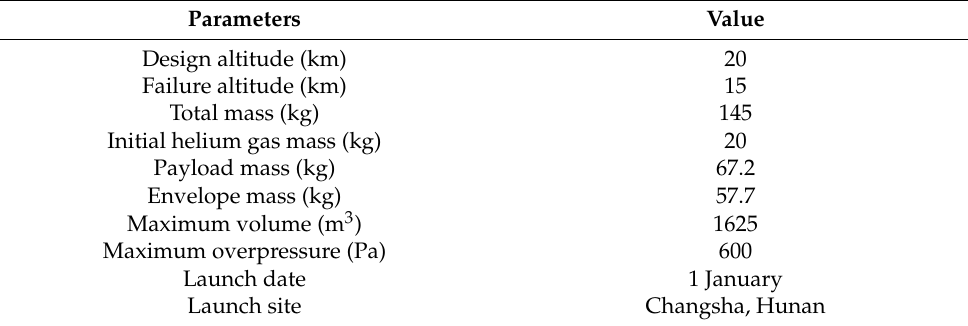
Table 3. Main parameters of the aerostat used for the simulation.